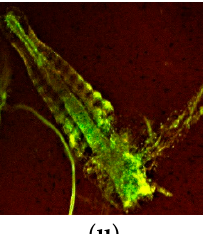
Figure 3. A. salina larvae after the exposure to F-UBE-HPMC ( a – p )—microscopic images at 100×